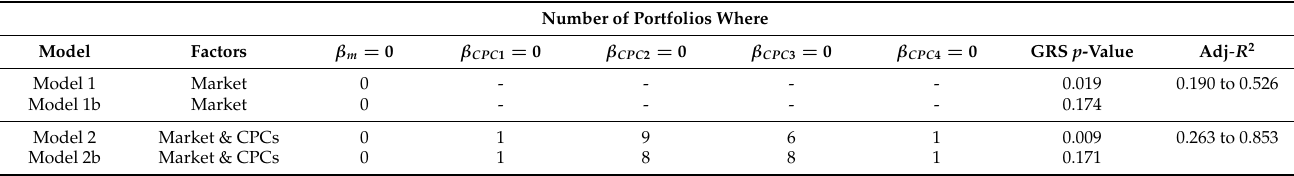
Table 12. Comparison of classical methodologies and bootstrap methods. Number of Portfolios